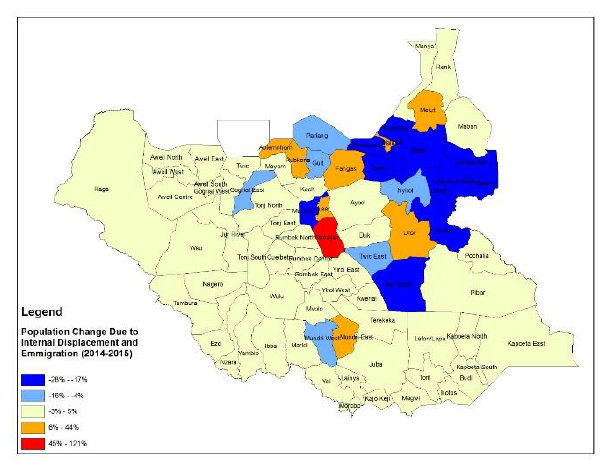
Figure 9. Population Change Due to Internal Displacement and Refugee